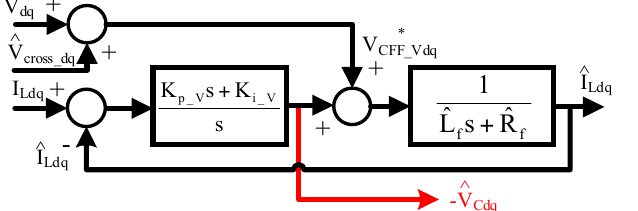
Figure 4. Proposed first closed-loop observer in Figure 2 for capacitor voltage estimation (capacitor voltage observer).